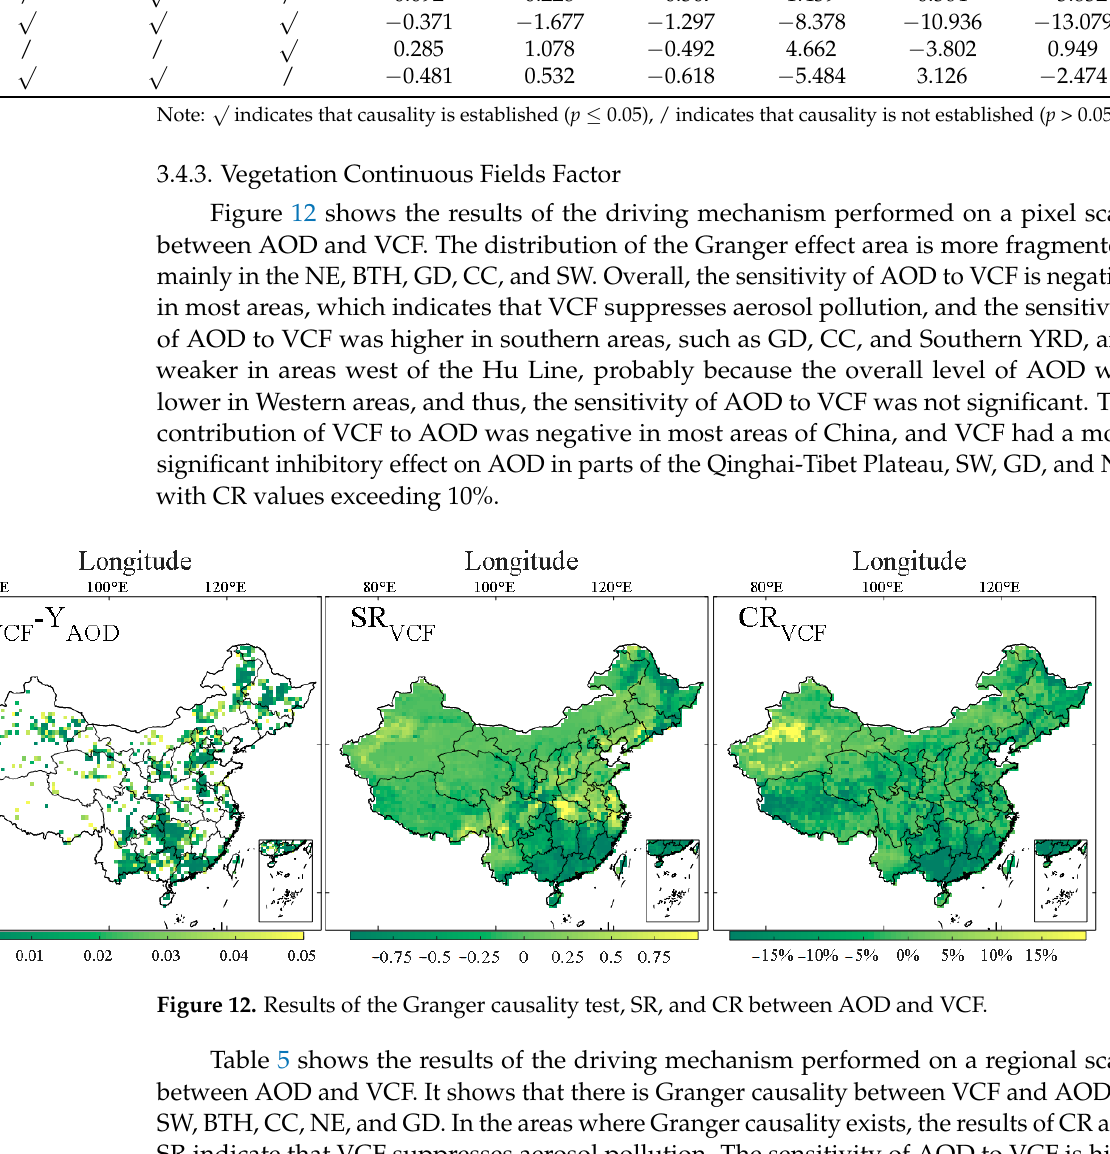
Table 5. Driving force analysis performed on a regional scale between AOD and VCF in major regions in China.